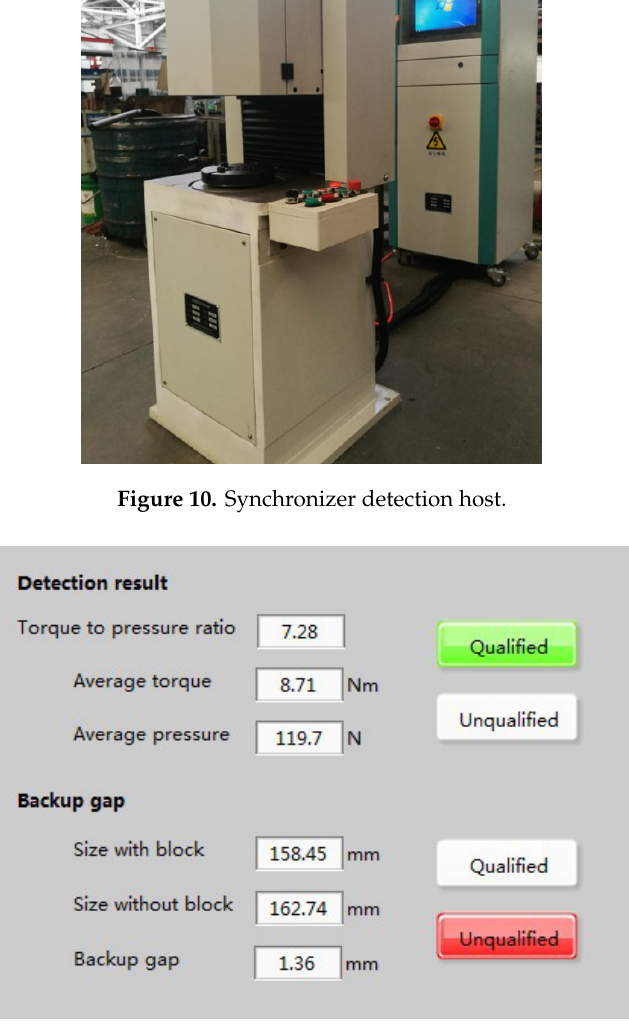
Figure 11. Partial operation results of the system program.